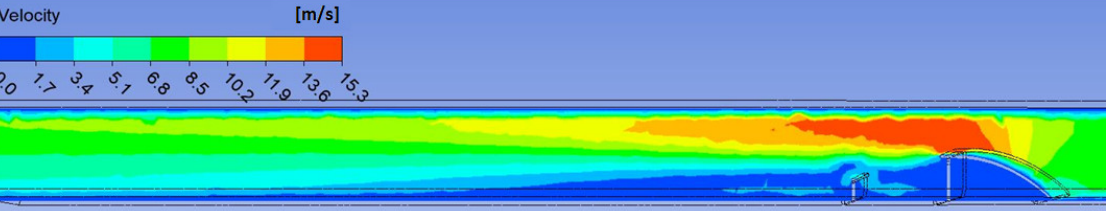
Figure 14. Air velocity; beam without deflectors; longitudinal section in centerline (CFD model with a beam size of 288 mm, inlet air velocity of 7.9 m/s).